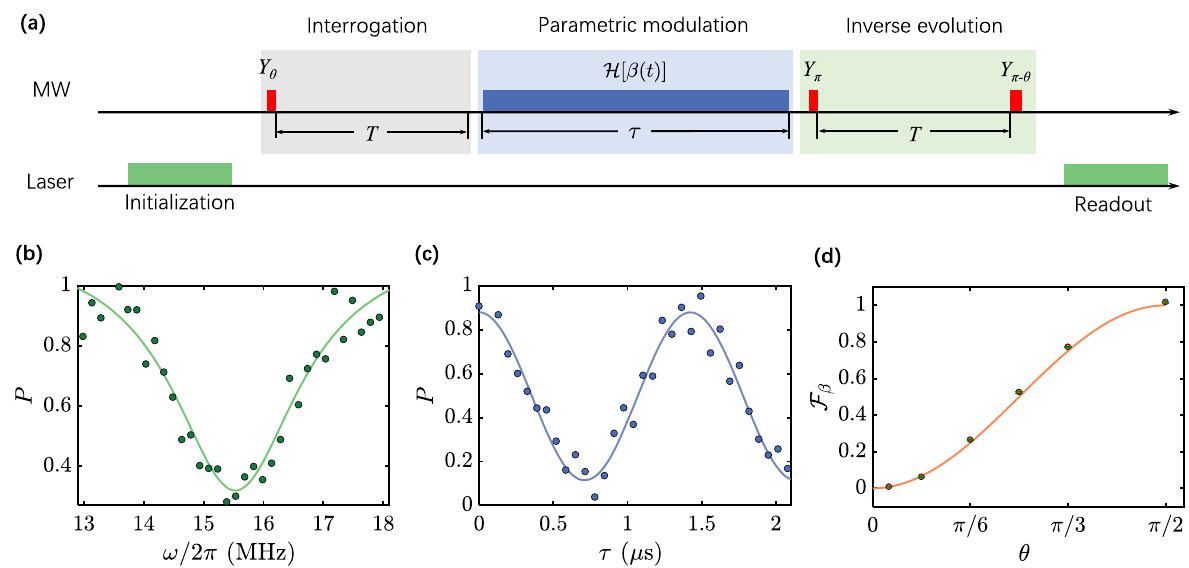
θ ð 0 Þj i is prepared via a β Þj i back to the state 0 j i , θ ð (cid:7) (cid:6) (cid:7) β Þj i and ψ ? β Þ under parametric modulation. The other experiment θ ð θ ð